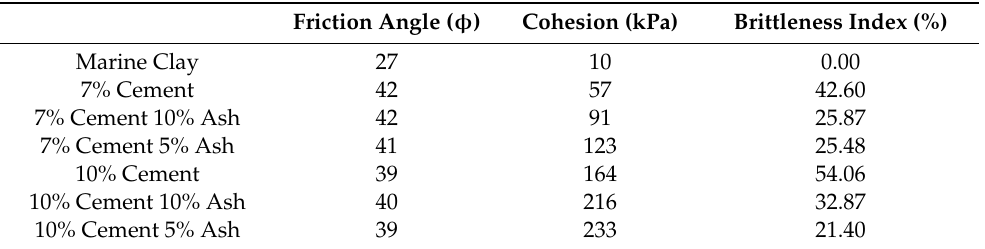
Table 4. Shear strength parameters and average brittleness ratio of all blends.